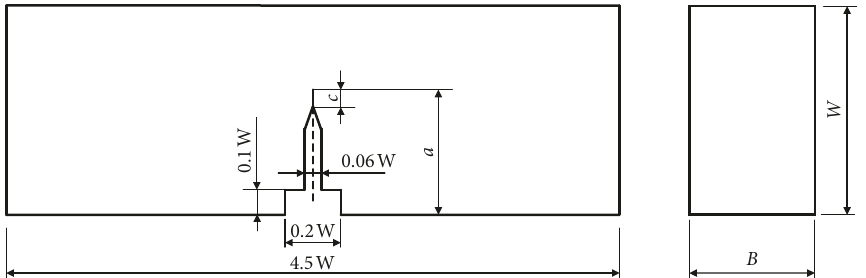
Figure 3: Geometry size of three-point bending specimen, where W � 60mm, a � 0.5W, c � 3mm, and B � 0.5 W.